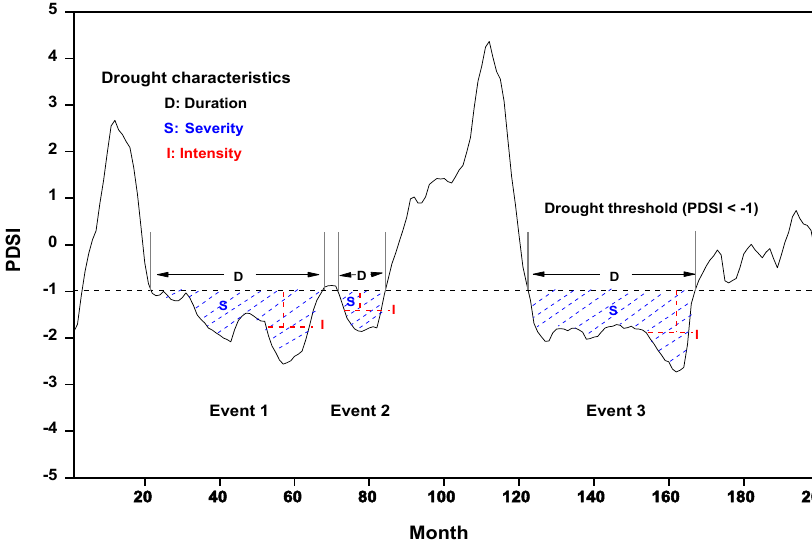
Figure 2. The Palmer Drought Severity Index (PDSI)-based drought characteristics definition through the run